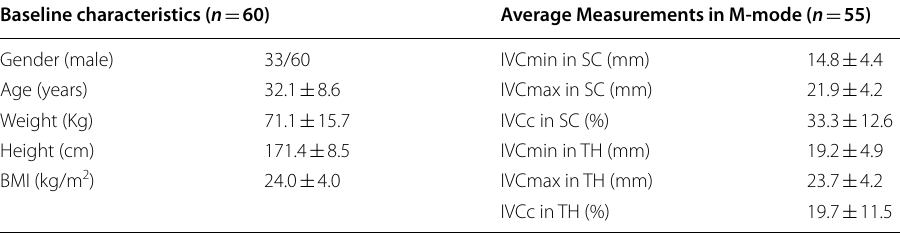
Table 1 Baseline characteristics of included volunteers Baseline characteristics ( n